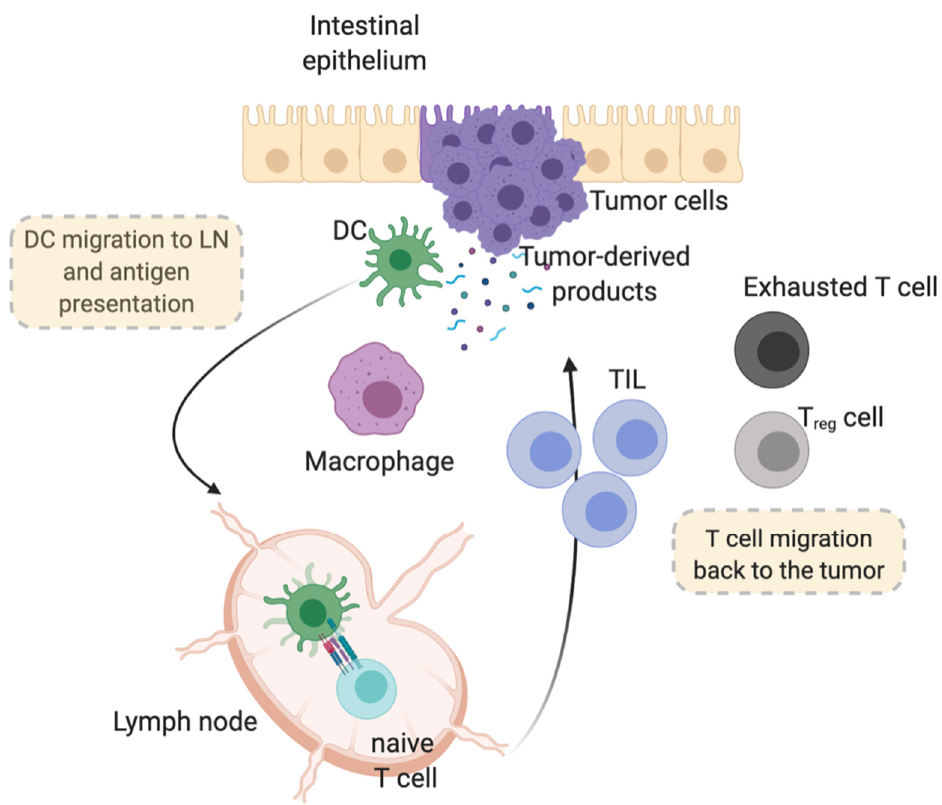
Figure 1. Scheme of the cancer immune cycle, depicting antigen-presenting cells (mostly dendritic cells, DC), which infiltrate the tumor tissue, uptake tumor-derived products and traffic to draining lymph nodes, therein presenting antigens to antigen-specific cytotoxic T cells. Sustained immunosuppressive circuits may induce T-cell dysfunction, immune escape and eventually cancer progression.